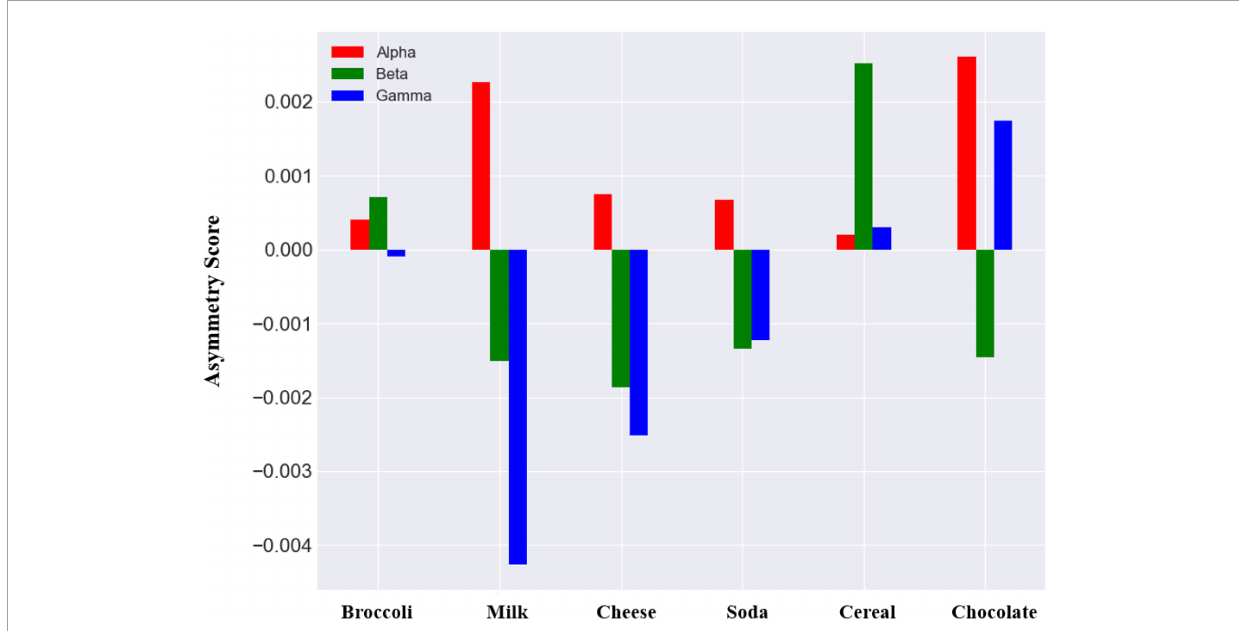
FIGURE6 Asymmetry scores in alpha, beta, and gamma frequency bands for each item in planned purchase. Asymmetry scores in alpha have been multiply by negative 1 to represent a same behavior as other frequency bands.